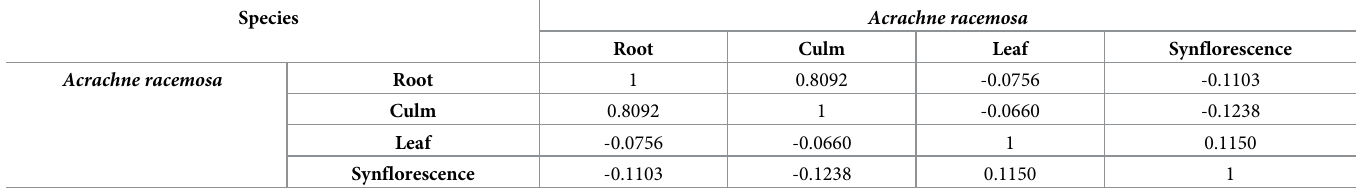
Table 7. Coefficient correlation among the phytolith morphotypes from different parts of Acrachne racemosa (Heyne. Ex roem. & Schult.) Ohwibased on the Pear- son’s